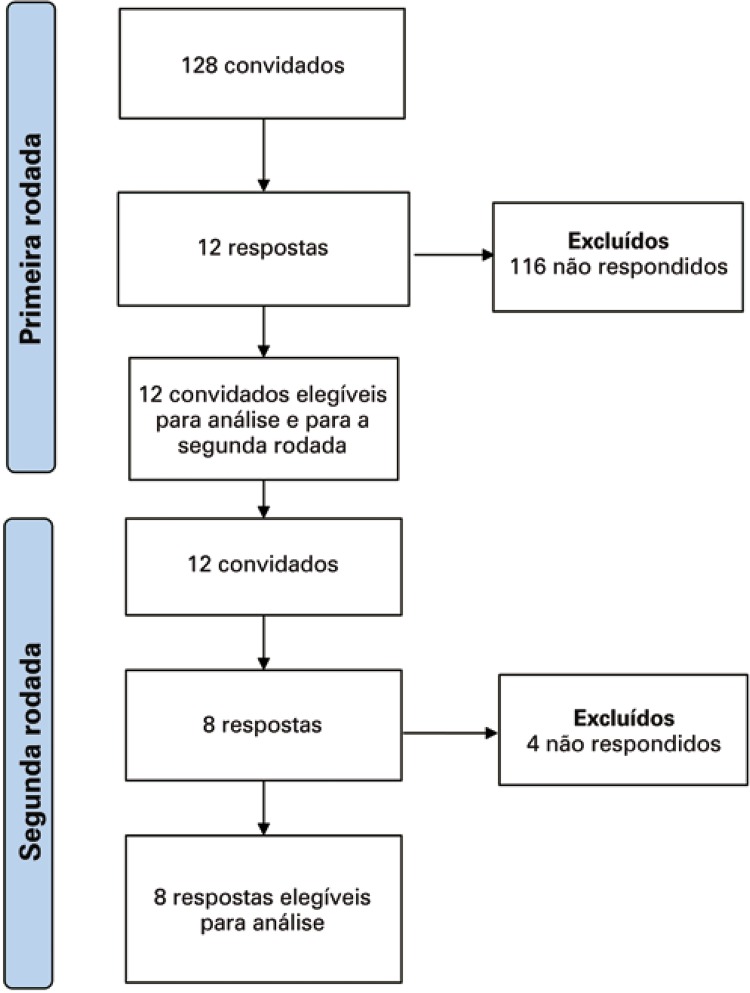
Fluxograma de respostas da primeira e segunda rodada